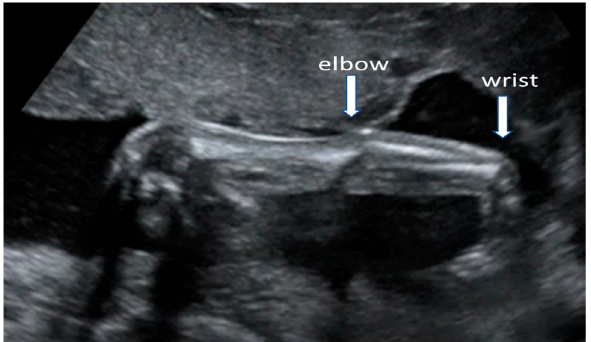
Figure 2. Ultrasound scan of a 22 weeks fetus with arthrogryposis multiplex congenita showing extended right upper extremity with fixed joints: elbow in extensions and wrist in flexion.